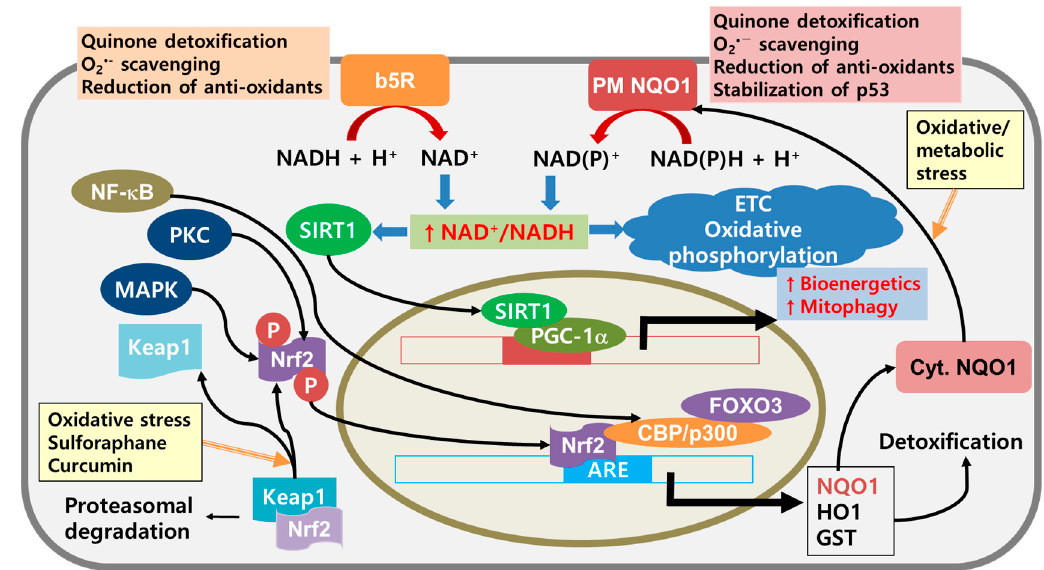
Figure 4. Redox homeostasis and metabolic shift through activation of the Nrf2-Keap1 pathway and regulation of the NAD + /NADH ratio by PM redox enzymes. Disulfide bonds between Nrf2 and Keap1 are broken by oxidative stress and other Nrf2 activators. Activated Nrf2 is translocated into the nucleus, combined with CBP/p300 and FOXO3, and bound to ARE, which results in the expression of detoxifying enzymes. Under further oxidative/metabolic stress, expressed cytosolic NQO1 can be translocated into the inner surface of the PM. A high NAD+/NADH ratio is induced by stimulating b5R and PM NQO1 to activate SIRT1-PGC-1 α signaling and enhance mitochondrial bioenergetics.